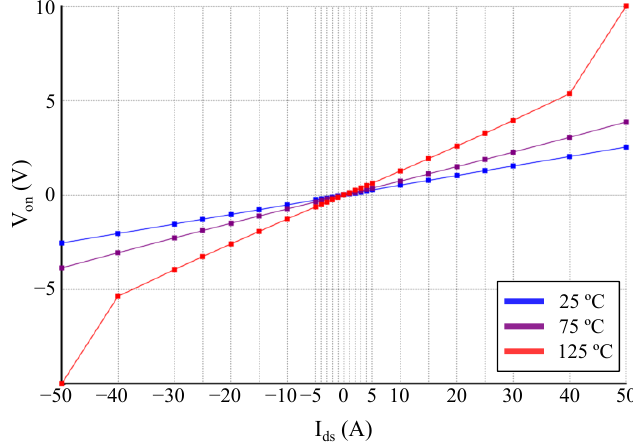
Figure 9. GaN e-HEMT conduction losses look-up table.